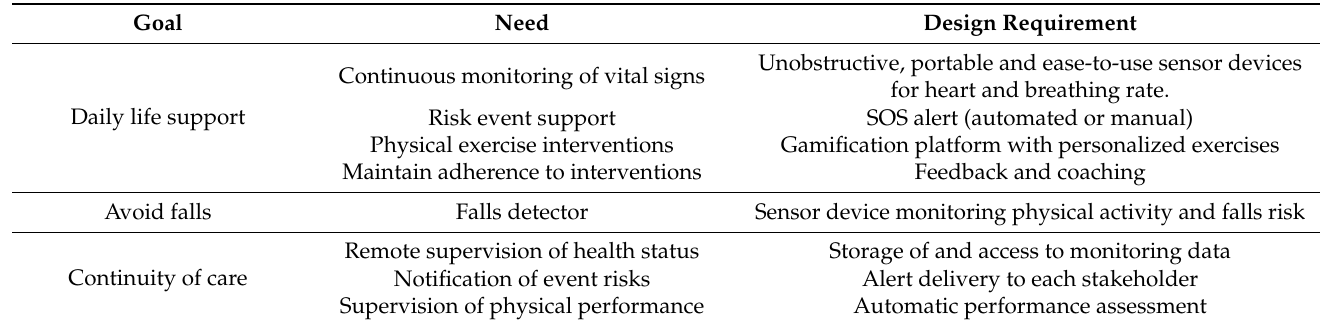
Table 1. User design